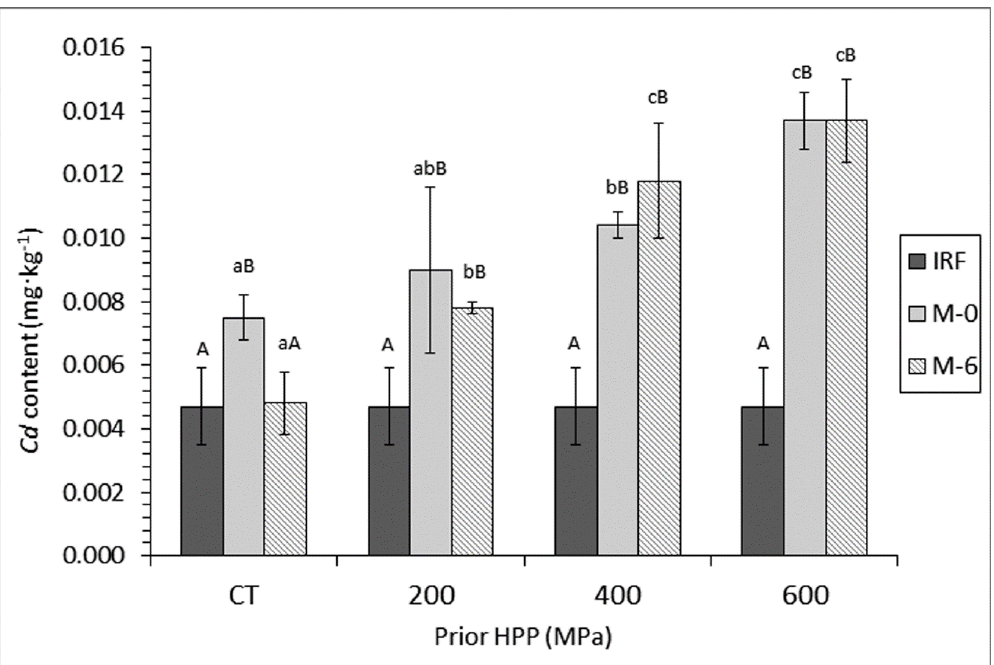
Figure 3. Determination of Cd content (mg·kg −1 dry muscle) * in initial raw fish (IRF) and canned mackerel subjected to high-pressure processing (HPP), freezing, and frozen storage **. * Mean values of three replicates ( n = 3). Standard deviations are indicated by bars. For each frozen storage time (0 or 6 months), different lower-case letters (a–c) denote significant differences ( p < 0.05) as a result of HPP. For each HPP condition, capital letters (A, B) denote significant differences ( p < 0.05) as a result of frozen storage time. ** Sample name abbreviations as expressed in Figure 1.